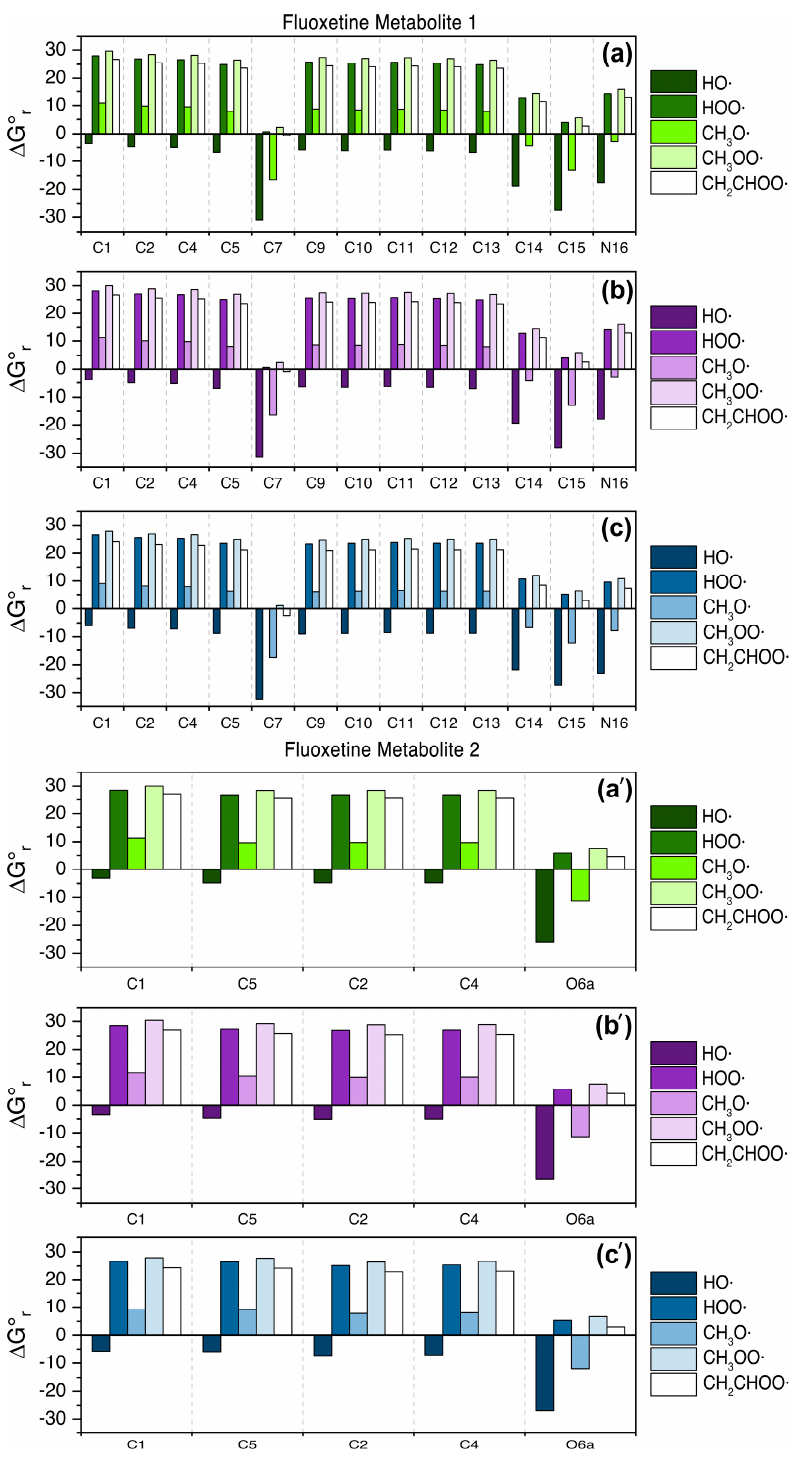
Figure 4. Δ G° HAT (kcal mol − 1 ) in gas-phase for fluoxetine metabolite 1 ( a ) and fluoxetine metabolite 2 ( a’ ), in benzene for fluoxetine metabolite 1 ( b ) and fluoxetine metabolite 2 ( b’ ), and in water for fluoxetine metabolite 1 ( c ) and fluoxetine metabolite 2 ( c’ ) for the scavenging of HO • , CH 3 O • , HOO • , CH 3 OO • , and CH 2 = CHOO • through HAT from all the available sites of fluoxetine metabolite 1 ( M1 ) and metabolite 2 ( M2 ). Level of theory: (SMD)-M06-2X / 6-311 + G(d, p) // M06-2X /